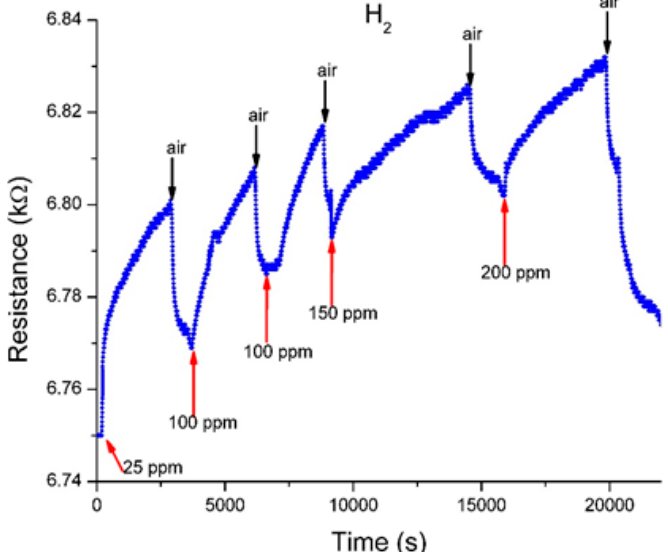
Figure 10. The sensor response to exposure at different concentration of H 2 in N 2 .